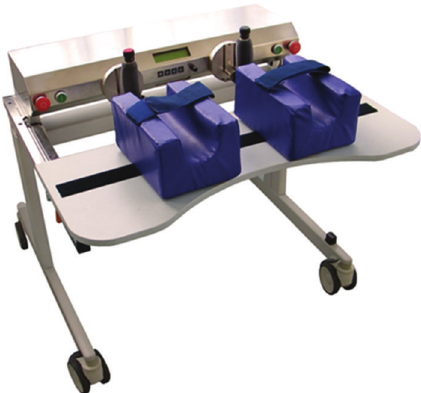
Figure 13: Bi-Manu-Track. Reprinted with permission (http://